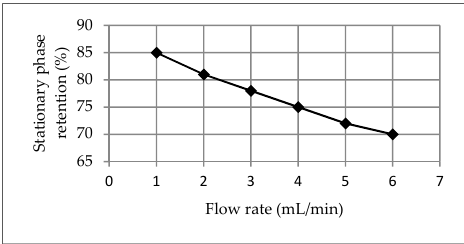
Figure 2. Effect of the mobile phase flow rate over the stationary phase retention. Mobile phase: Lower phase of the biphasic solvent system 7 ( n -Hep:EtOH:H 2 O, 2:4:4, v / v / v ).